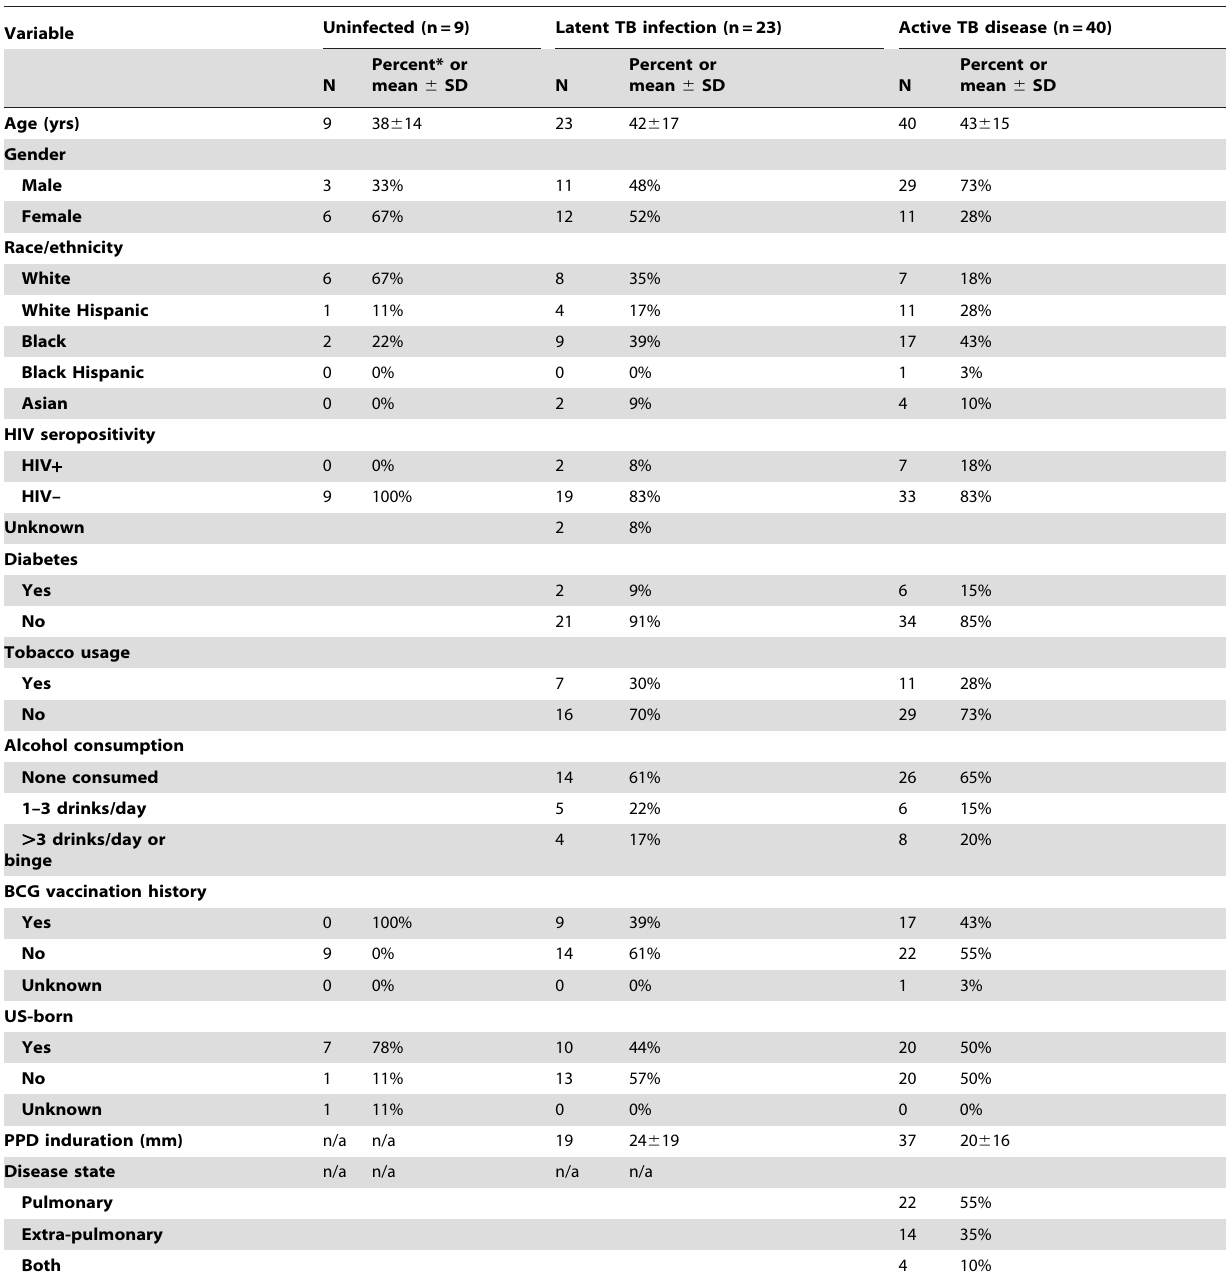
Table 1. Demographic and clinical